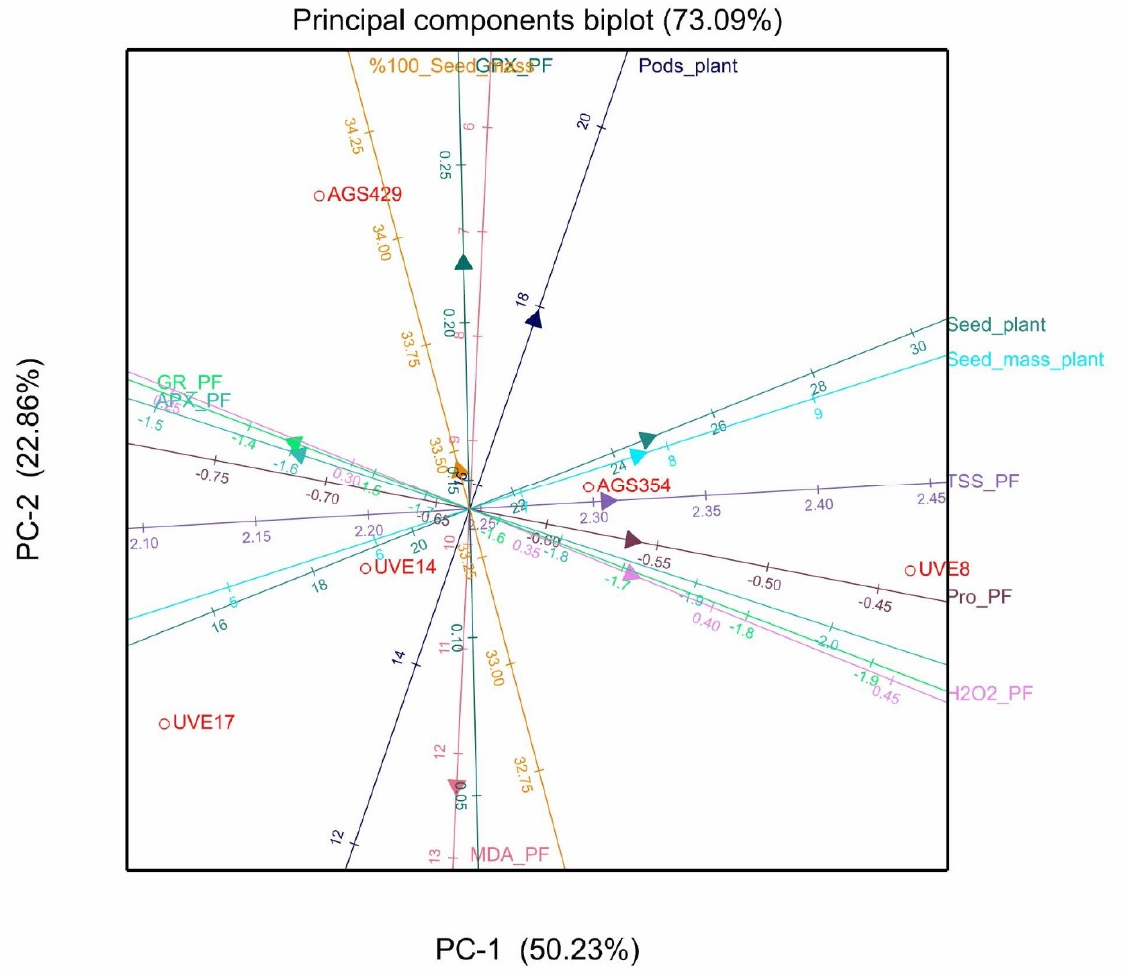
Figure 9. Principal components biplot between PC1 and PC2 showing the contribution of biochemical and yield parameters to the variability of five vegetable-type soybean cultivars subjected to severe stress at pod filling.